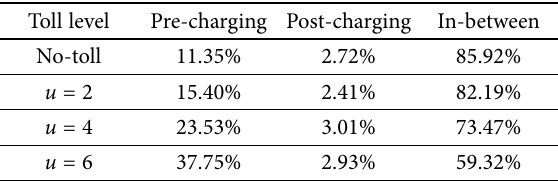
Table 3. Percentages of demand departing before